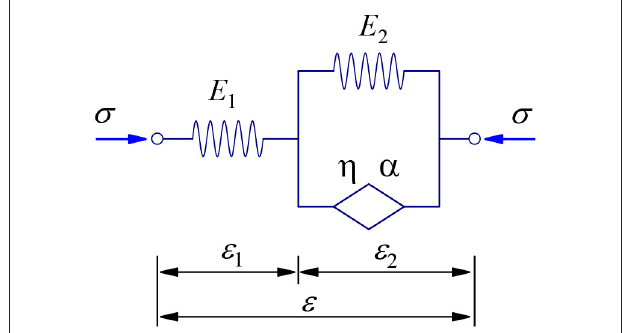
FIGURE 2 | Fractional derivative Merchant (FM)